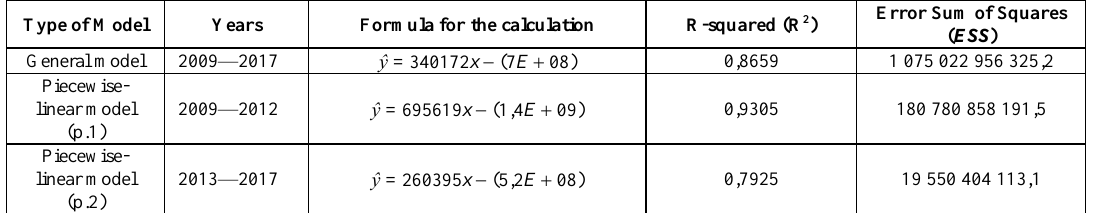
Error Sum of Squares ( ESS